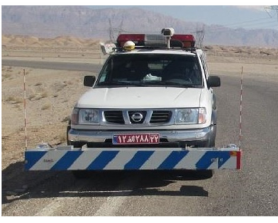
Figure 2. The RSP device used in this research.